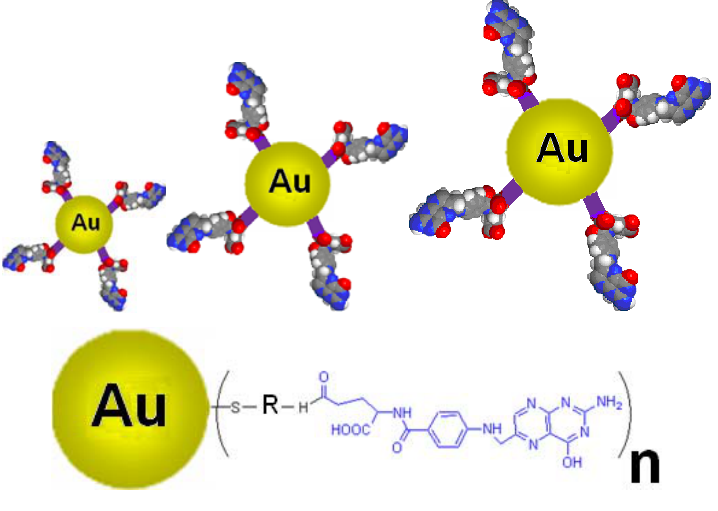
Figure 2. Schematics of a nanoconjugate of gold nanoparticle with folate